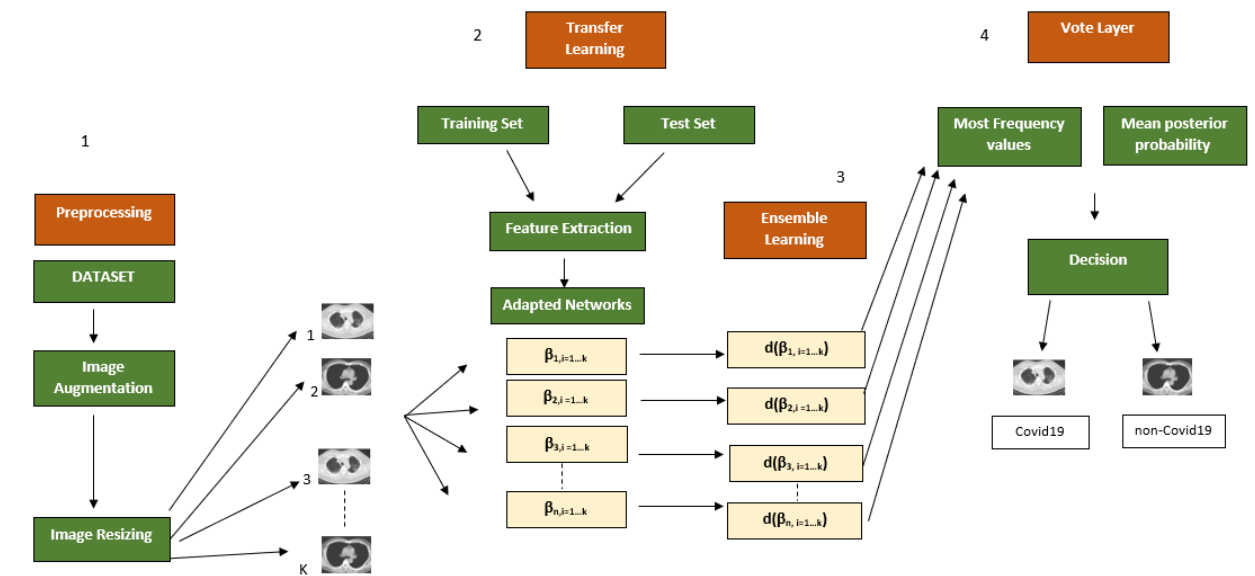
Figure 1. Overview of the proposed framework. The steps of the pipeline are numbered progressively and are accompanied by arrows indicating the data flow analysis. Step 1 indicates image preprocessing as described in Sections 3.1 and 3.2. Step 2 includes the application of different deep neural networks for the classification task. Step 3 illustrates the ensemble approach as described in Section 3.4. Finally, step 4 shows the vote process for the final decision as described at the end of Section 3.4.